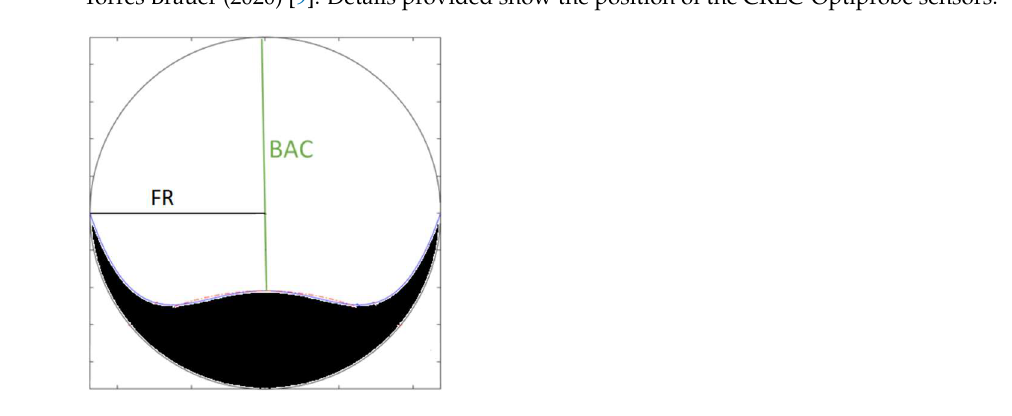
Figure 2. An axial cross-section of the HSCE model bubble. The white region represents air, and the black region represents the wake (a mix of air and sand) (Adapted from Torres Brauer et al. [19]).